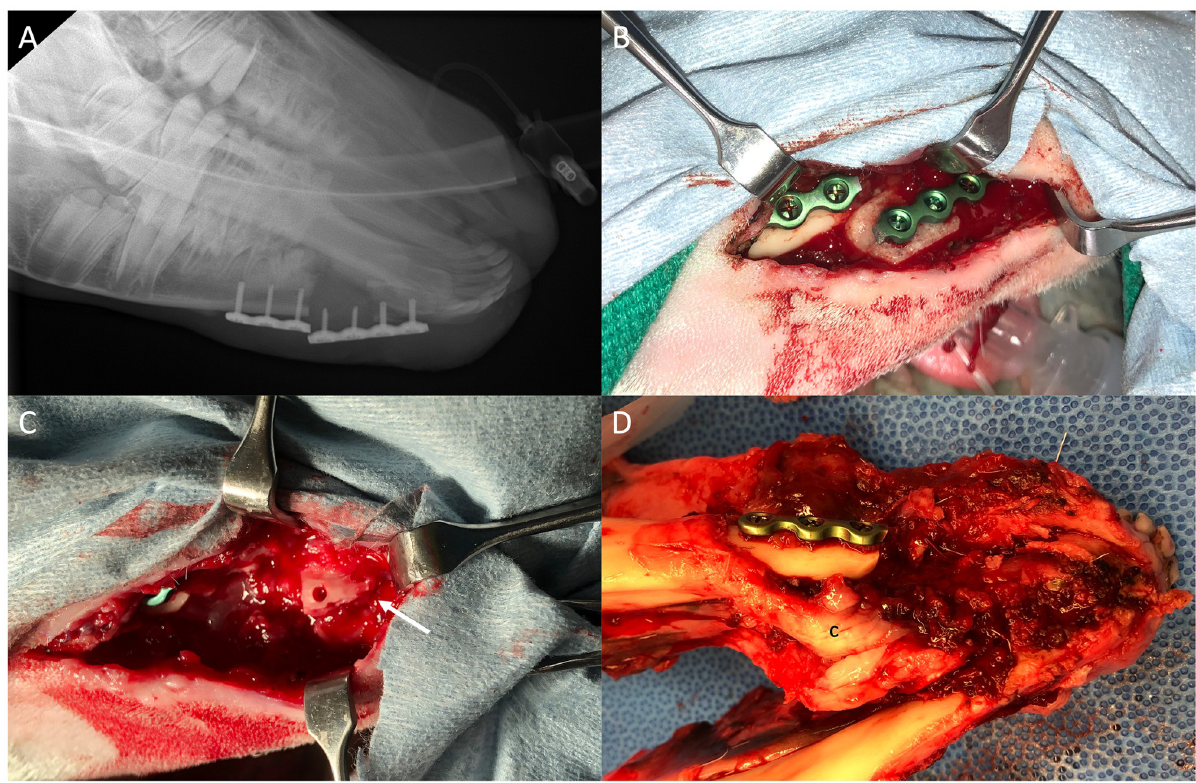
Fig 2. The removal of sheep from the study due to plate fracture. Pre-operative x-rays taken prior to attempted repair of unstable mandible (A); the plate fracture as visualized in the operating room (B); the fractured anterior mandible indicated by arrow (C); and the mandible removed after necropsy showing medial callus formation (c) and badly fractured anterior mandible